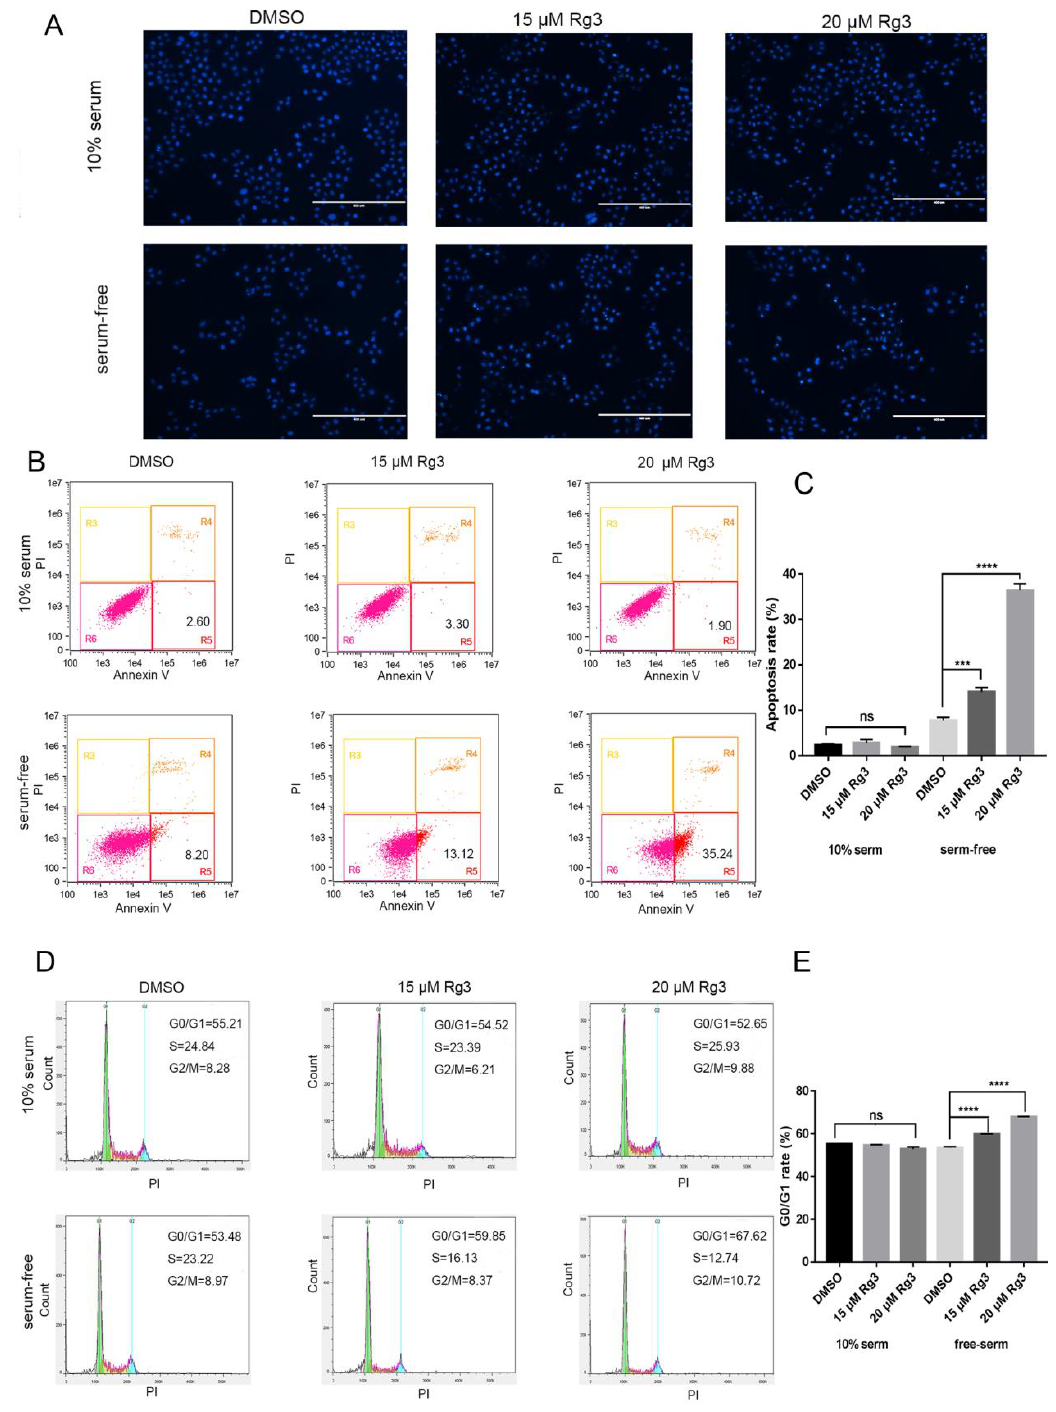
Figure 2. 20( S )-GRg3 increases apoptosis and regulates the cell cycle. ( A ) Hoechst 33342 staining of Hela cells treated with 20(S)-GRg3 for 24 h. Apoptosis was characterized by chromatin condensation and nuclear fragmentation. ( B ) Flow cytometric analysis of the apoptosis ratio. The total apoptotic cell ratio was the sum of cells undergoing early apoptosis (lower right) and late apoptosis (upper right). Control cells received an equal volume of 0.1% DMSO. ( C ) Statistical analysis of apoptosis determined by the flow cytometric evaluation. ( D ) Flow cytometric analyses of the cell cycle distribution of Hela cells treated with di ff erent 20( S )-GRg3 concentrations under normal or serum-deprived conditions for 24 h. ( E ) Statistical analysis of the cell cycle distribution. *** p < 0.001, **** p < 0.0001, ns >